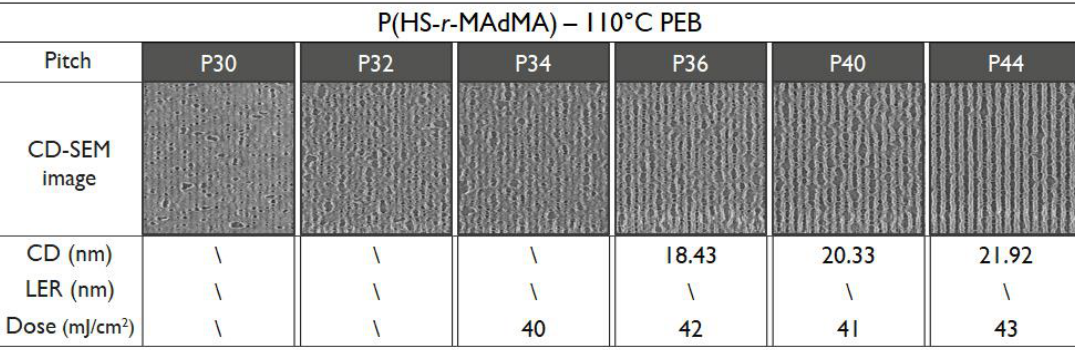
Figure 13. Patterning performance of the P(HS- r -MAdMA) polymer-based resist at 130 °C PEB.